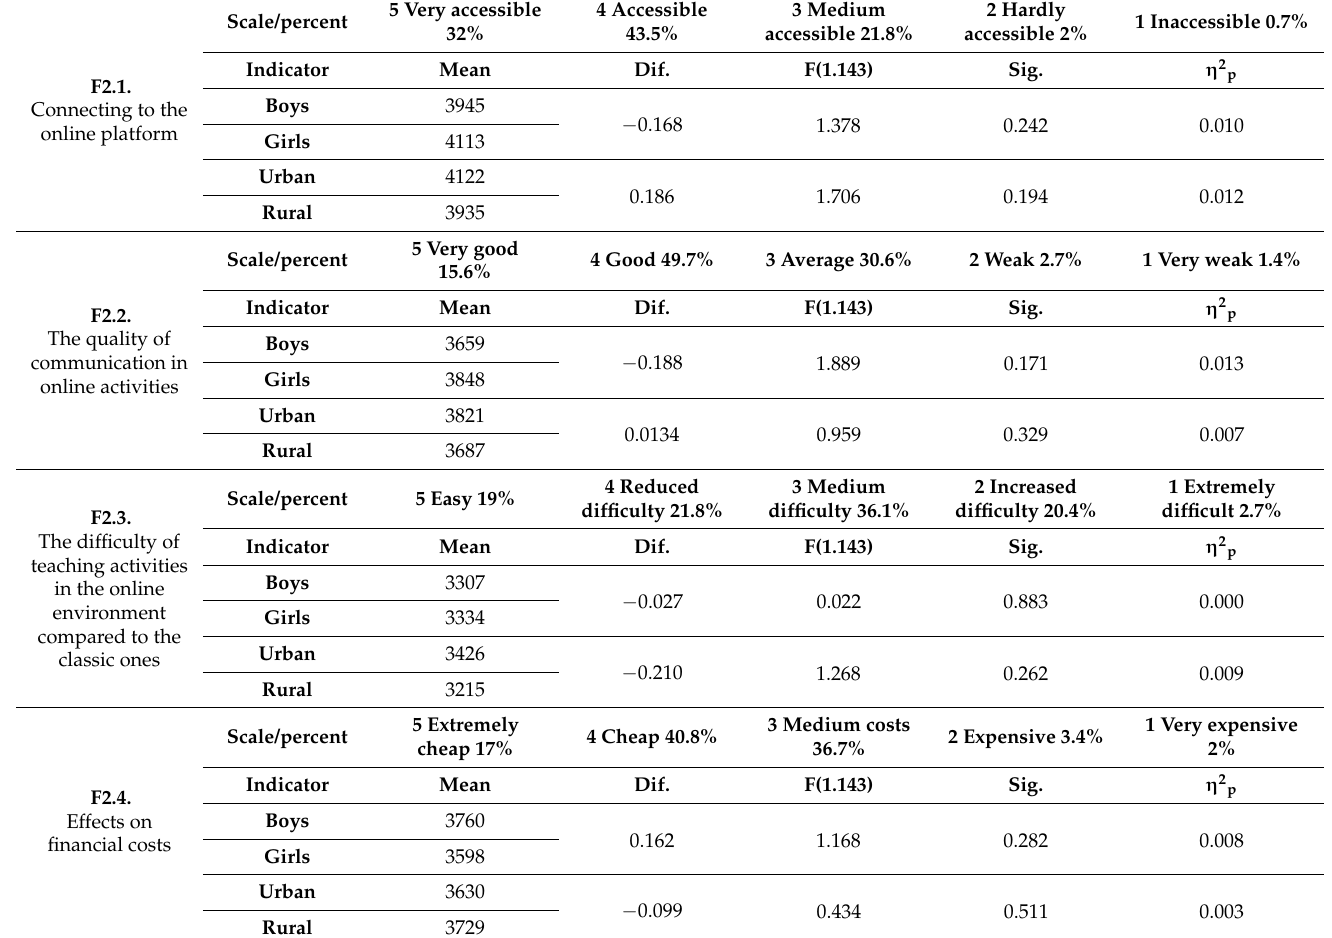
Table 6. The results of the questionnaire for the accessibility factor (univariate